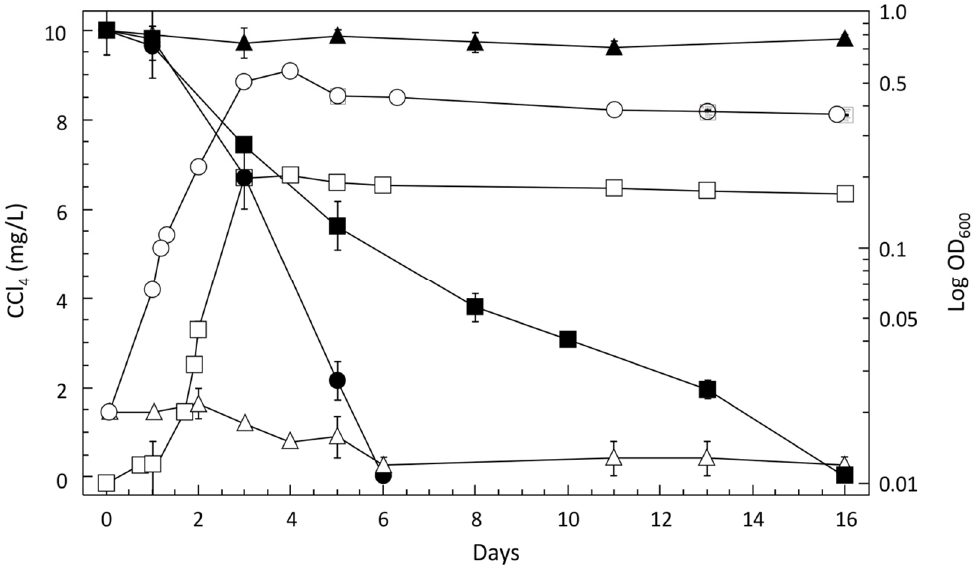
Figure 3. CCl 4 degradation during growth of Pelosinus sp . TM1. Optical density (open symbols) and CCl 4 degradation (filled symbols); cultivation with 10 mg·L − 1 CCl 4 in anoxic C medium (circles), C medium exposed to oxygen for one week (triangles), and anoxic SGW medium (squares). Error bars represent the standard error of 3 technical